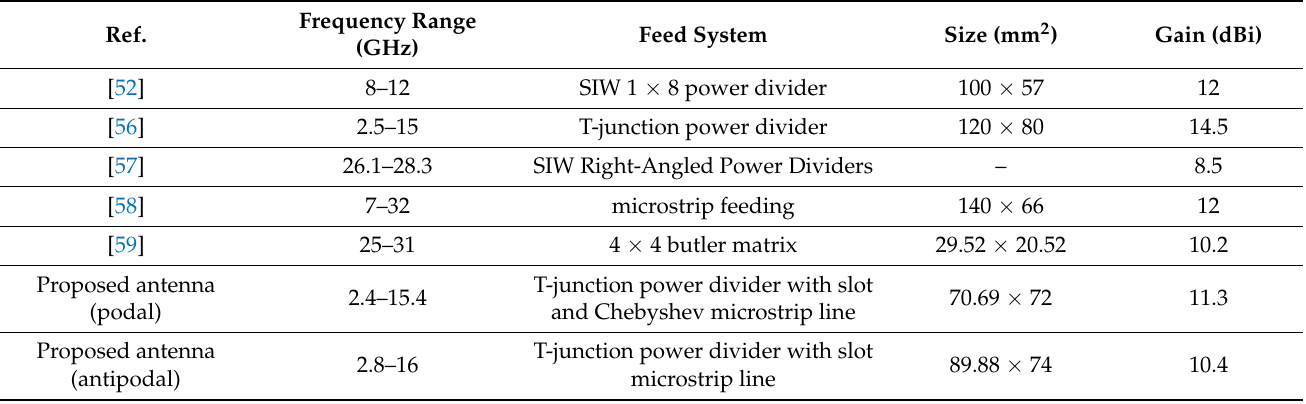
Table 2. Comparison of the proposed antennas with other antennas in terms of gain, size, and feed system.